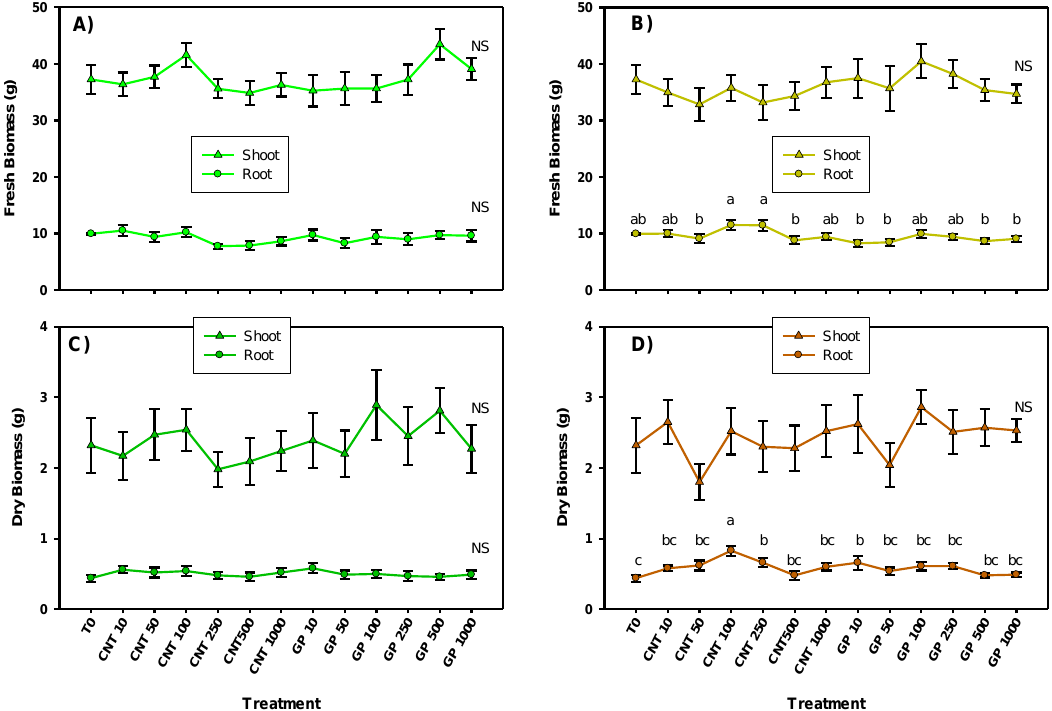
Figure 1. Shoot and root biomass of tomato seedlings with carbon nanomaterials applied via foliar ( A , C ) and drench ( B , D ). T0: control; CNTs: carbon nanotubes; GP: graphene; DW: dry weight; 10, 50, 100, 250, and 500 represent the mg L − 1 applied of each carbon nanomaterial. Different letters indicate significant differences among treatments according to Duncan ( α = 0.05). n = 5 ± standard error.